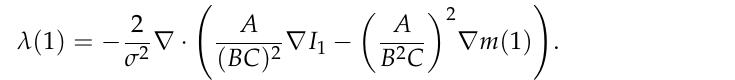
Table A1. Scalar fields from the gradients and Hessians of St-LDDMM with the different E img metrics considered in this work. The values of A , B , C , and Θ are analogs of the ones derived in the main manuscript for PDE-LDDMM replacing m ( 1 ) with I 0 restriction of the computation to a neighborhood of size ν